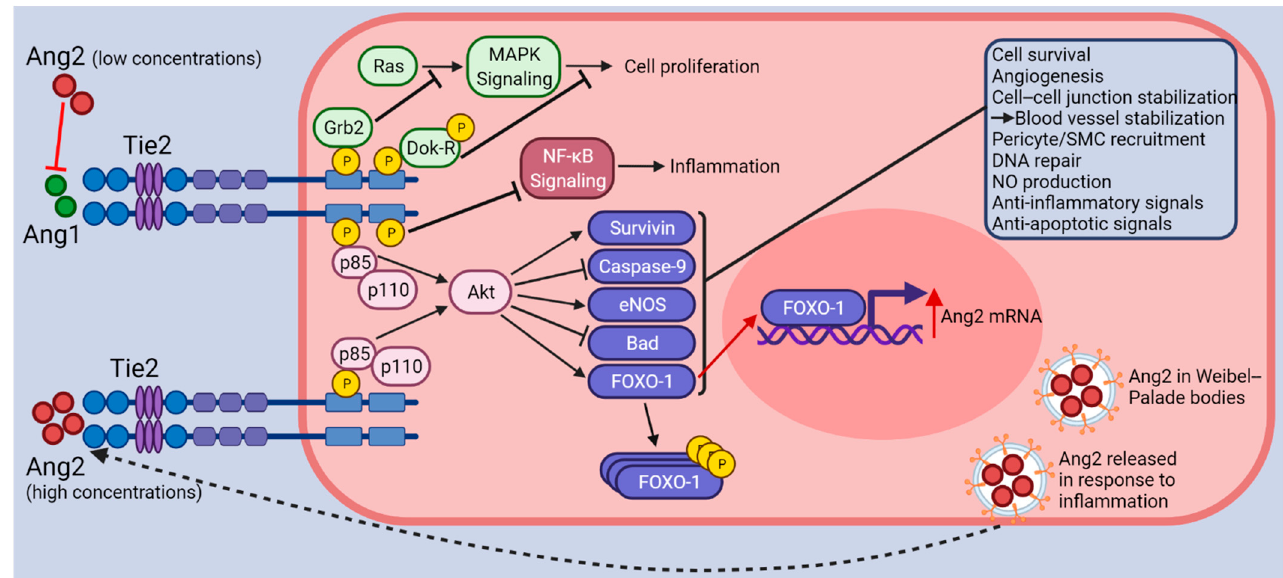
Figure 1. Illustration of Ang-Tie2 signaling. The Tie2 receptor undergoes autophosphorylation upon binding of Ang1. Subsequently, PI3K (p85/p110) and Akt signaling are activated, which in turn promote survival and anti-apoptotic signals through the upregulation of Survivin and eNOS and the inhibition of Caspase-9 and Bad. FOXO-1 transcription factors are involved in protein synthesis. Following Tie2 activation (effects shown with black arrows and inhibitor lines), FOXO-1 is phosphorylated and inactivated, which promotes EC quiescence, survival, and vascular stabilization. Other proteins associated with phosphorylated Tie2 such as Grb2 and Dok-R inhibit cell proliferation. ABIN-2 (not shown) associates with phosphorylated Tie2 and is thought to prevent NF ‐κ B signaling activation through the inhibition of the IKK complex. Altogether, Tie2 activation (by Ang1 or high concentrations of Ang2) leads to vessel stabilization through EC survival, quiescence, and the stabilization of cell–cell junctions. When Ang2 binds to Tie2 at lower concentrations (effects shown with red arrows and inhibitor lines), it acts as a Tie2 antagonist preventing Ang1 from binding to Tie2. Acting as an antagonist to Tie2 signaling, Ang2 binding causes vessel destabilization, pericyte/SMC drop ‐ off, cell migration, inflammation, and vascular leakage. Under these conditions, the FOXO ‐ 1 transcription factors are activated and promote the transcription of Ang2 mRNA, vascular destabilization, and apoptosis. Finally, the Ang2 protein produced is stored in Weibel–Palade bodies, ready for release into the ECM upon the detection of inflammatory signals. Figure created with BioRender (accessed on 15 November 2021).